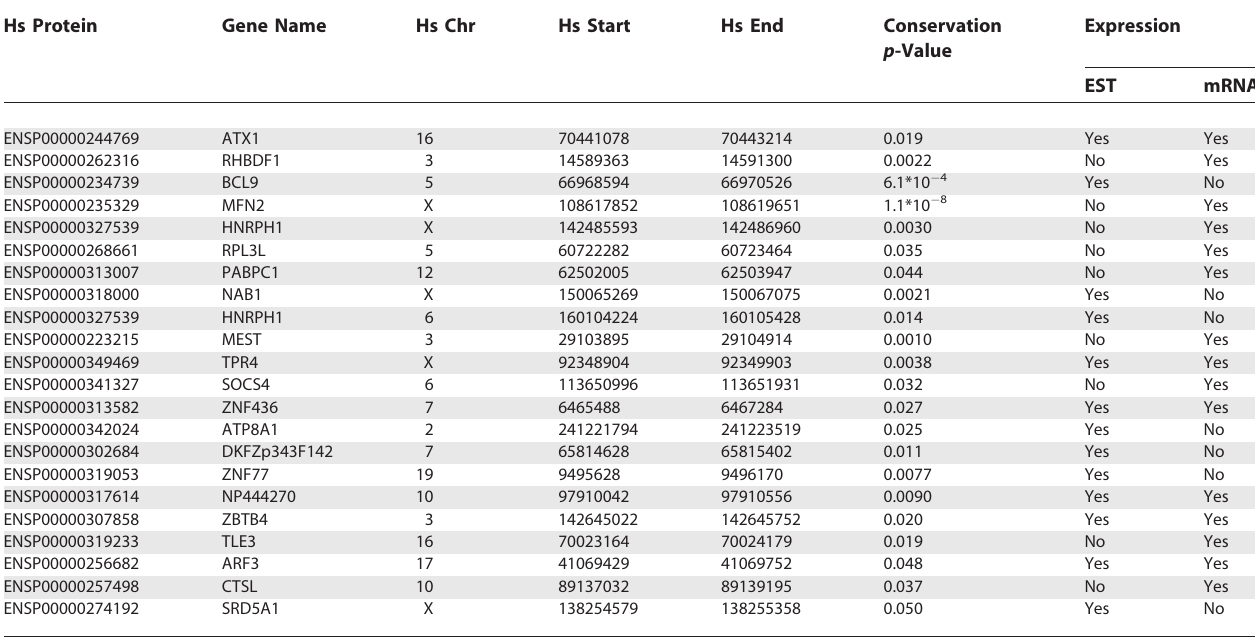
Table 7. Human–Chimpanzee Conserved and Expressed Pseudogene Pairs Hs